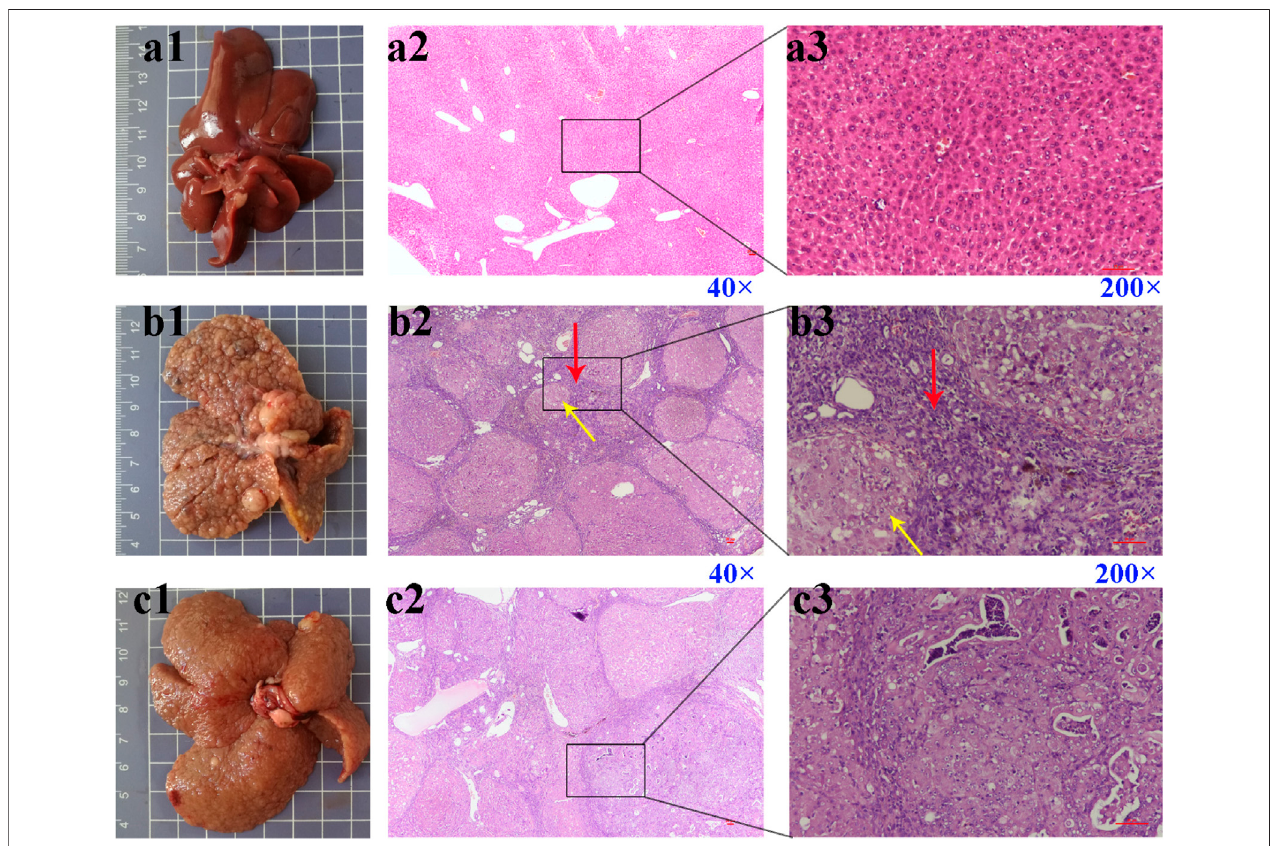
FIGURE 3 | Pictures (scale bar, cm) and H&E staining images of rat liver tissue. (a1 – a3) are the control group; (b1 – b3) are the DEN group; (c1 – c3) are the DEN + Febu group. Red arrow: proliferative fi brous connective tissue; Yellow arrow: pseudolobuli formation.